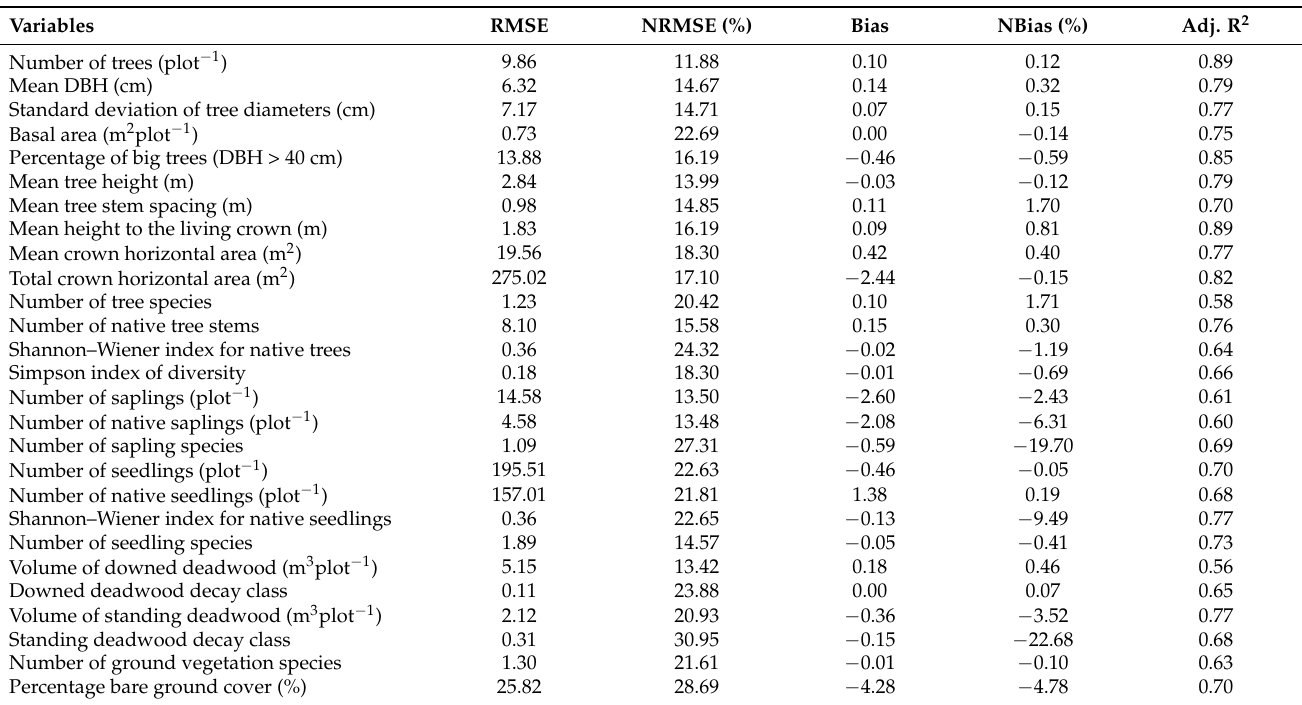
Table 4. Summary statistics of each random forest model using metrics from the leaf-on and leaf-off acquisition, with absolute and normalised root mean square error (RMSE and NRMSE); absolute bias and normalised bias (NBias); and the adjusted coefficient of determination (Adj. R 2